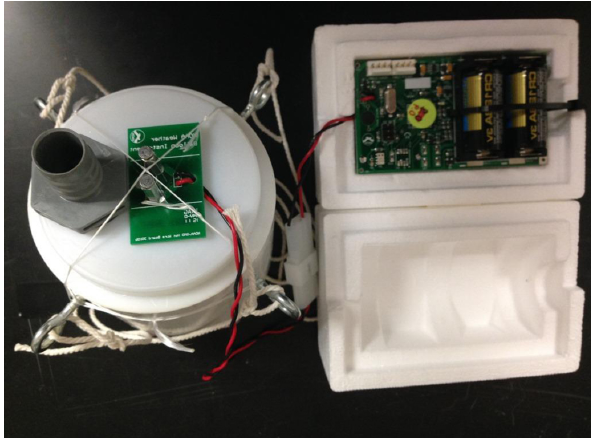
Figure 5. Automatic balloon valve (left) and pressure sensor assem- bly (right). Two thin strings anchoring the white circular pipe cap to the pipe are stretched across the hot wire string cutter. The foam box houses the pressure sensor, logic board and batteries. A cork is inserted in the gray helium fill port on the white pipe cap after the balloon is filled.